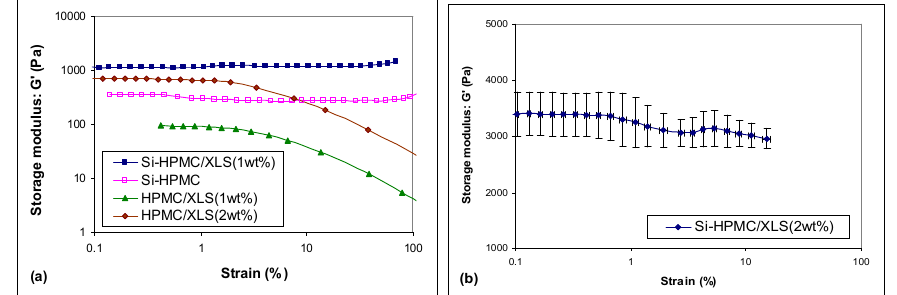
Figure 3. Storage modulus of ( a ) HPMC/XLS, pure Si-HPMC, Si-HPMC/XLS (1 wt %), and ( b ) Si-HPMC/XLS (2 wt %) composite hydrogel as function of strain after one day at 37 °C. The composite hydrogels were prepared using B and results represent mean ± SEM for n ≥ 3 samples.